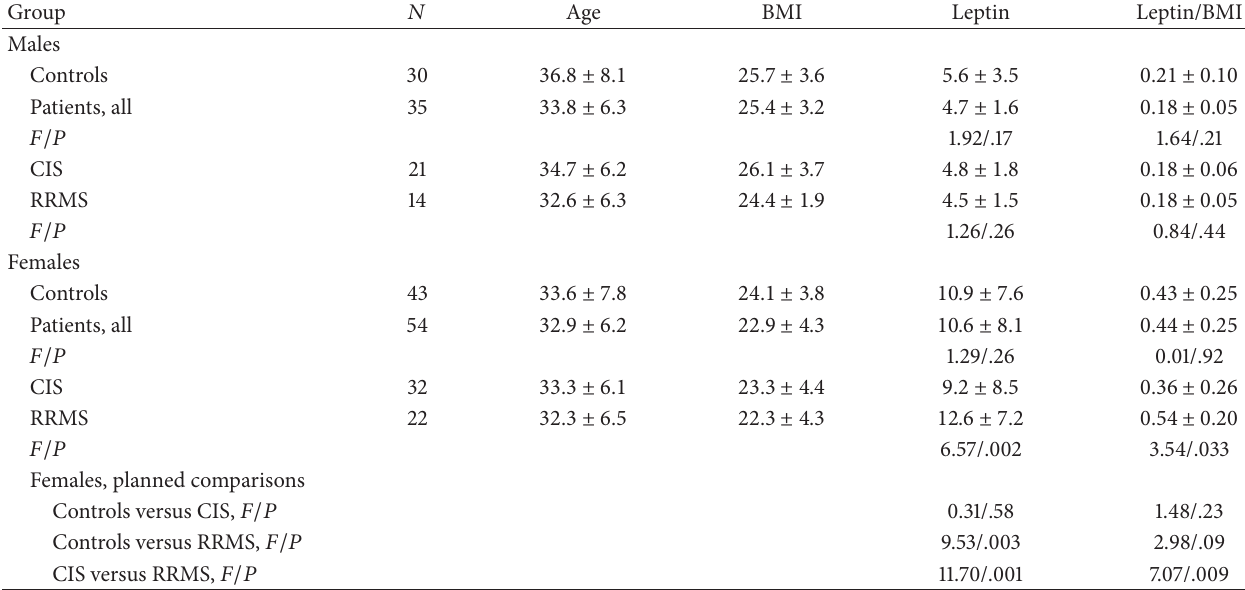
Table 2: Age, body mass index, serum leptin levels (ng/mL), and ratio leptin/BMI of controls and therapy-na¨ıve patients with clinically isolated syndrome suggestive of MS (CIS) or relapsing-remitting MS (RRMS). Mean values ± SD. Evaluation by ANOVA with age and BMI as covariates for leptin and age as covariate for leptin/BMI ratio.